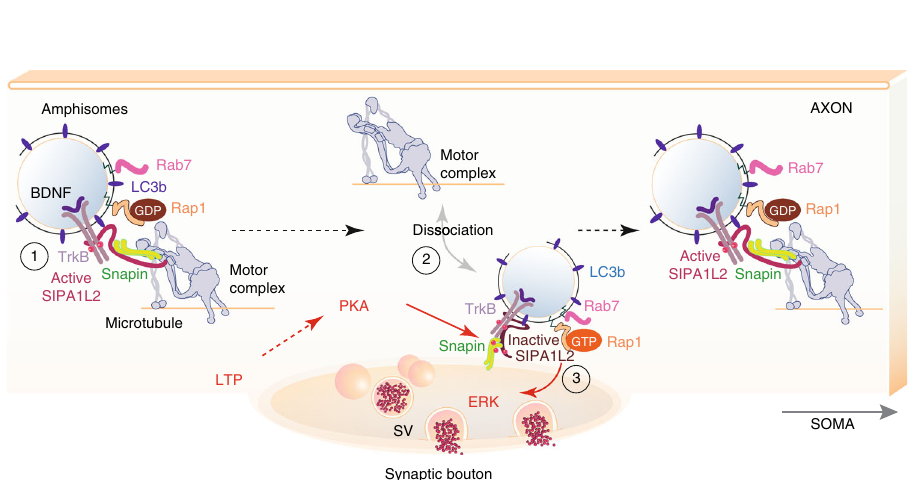
Fig. 9 SIPA1L2 controls traf fi cking and signaling of TrkB-amphisomes at boutons. Signaling amphisomes result from the fusion of active TrkB containing late endosomes with autophagosomes (1). Retrograde traf fi cking and signaling of these amphisomes in axons are tightly regulated by SIPA1L2, which directly binds to TrkB, Snapin, and LC3b. While the binding to Snapin serves as a linker to a dynein motor, binding of LC3b enhances SIPA1L2 RapGAP activity which negatively interferes with TrkB/Rap1-signaling and also slows down the velocity of retrograde transport. (2) The amphisome halts at single presynaptic boutons in a PKA-dependent manner. PKA-dependent phosphorylation of Snapin triggers its dissociation from the motor complex and immobilizing the amphisome at individual axon terminals. (3) PKA activity also terminates RapGAP activity by phosphorylating SIPA1L2 and allows TrkB/ Rap1 signaling that subsequently activates synaptic ERK and facilitates transmitter release.